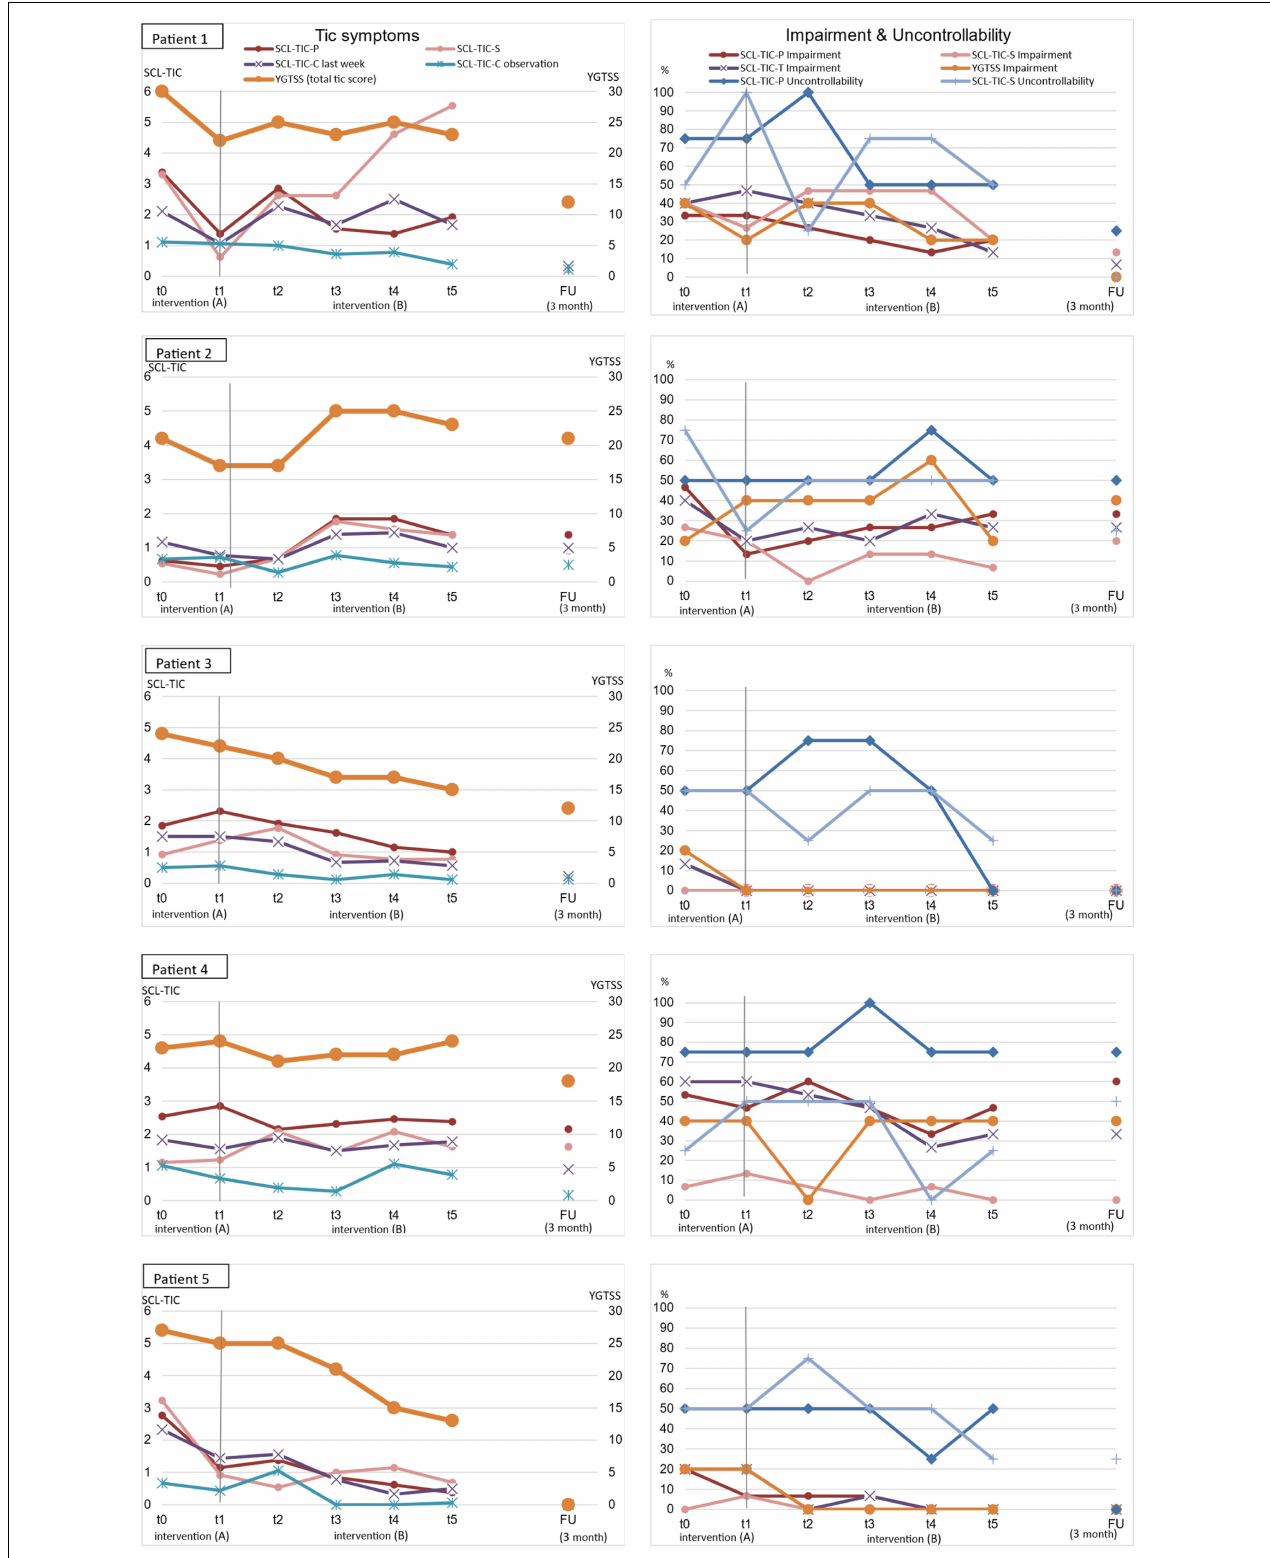
FIGURE 1 | Tic symptoms, impairment, and uncontrollability during intervention (A) and intervention (B) for each patient.